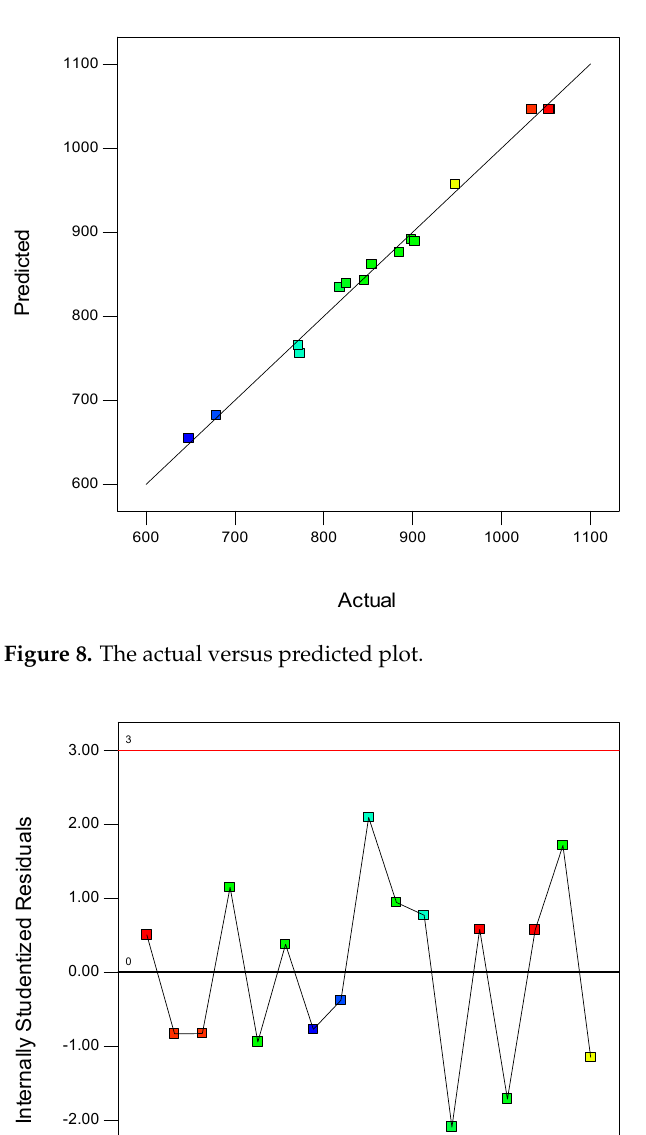
Figure 7. Normal percentage probability plot .